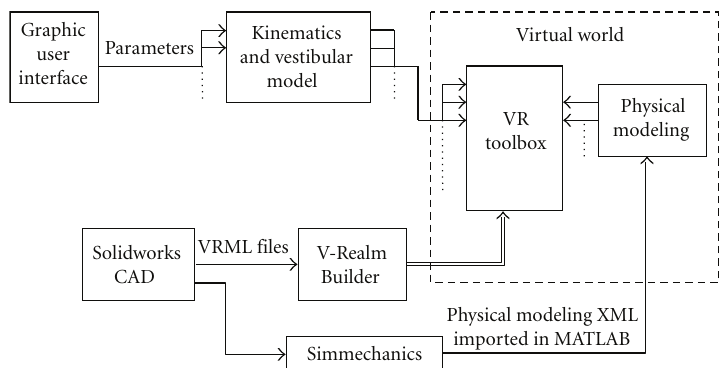
Figure 8: Schematic block diagram of how the virtual reality world is created and controlled. The VRML files are created using a CAD software. The Simmechanics module permits to represent and keep the physics of the modeling. All the data are imported into a MATLAB/Simulink model where the virtual reality toolbox is used. This Simulink file is controlled by the kinematics of the simulation and the vestibular